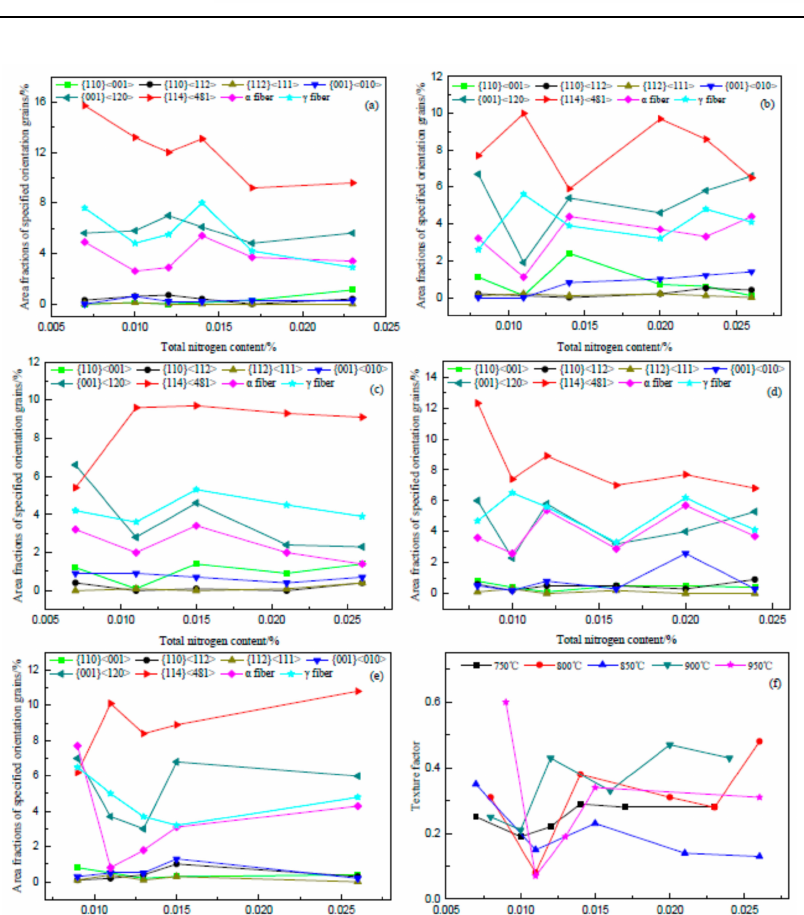
Figure 3. Relation between total nitrogen content and the area fractions of specified orientation grains and texture factor of a decarburized sheet after nitriding annealing at different tempera- tures: ( a ) 750 °C, ( b ) 800 °C, ( c ) 850 °C, ( d ) 900 °C, ( e ) 950 °C, and ( f ) 750 – 950 °C.